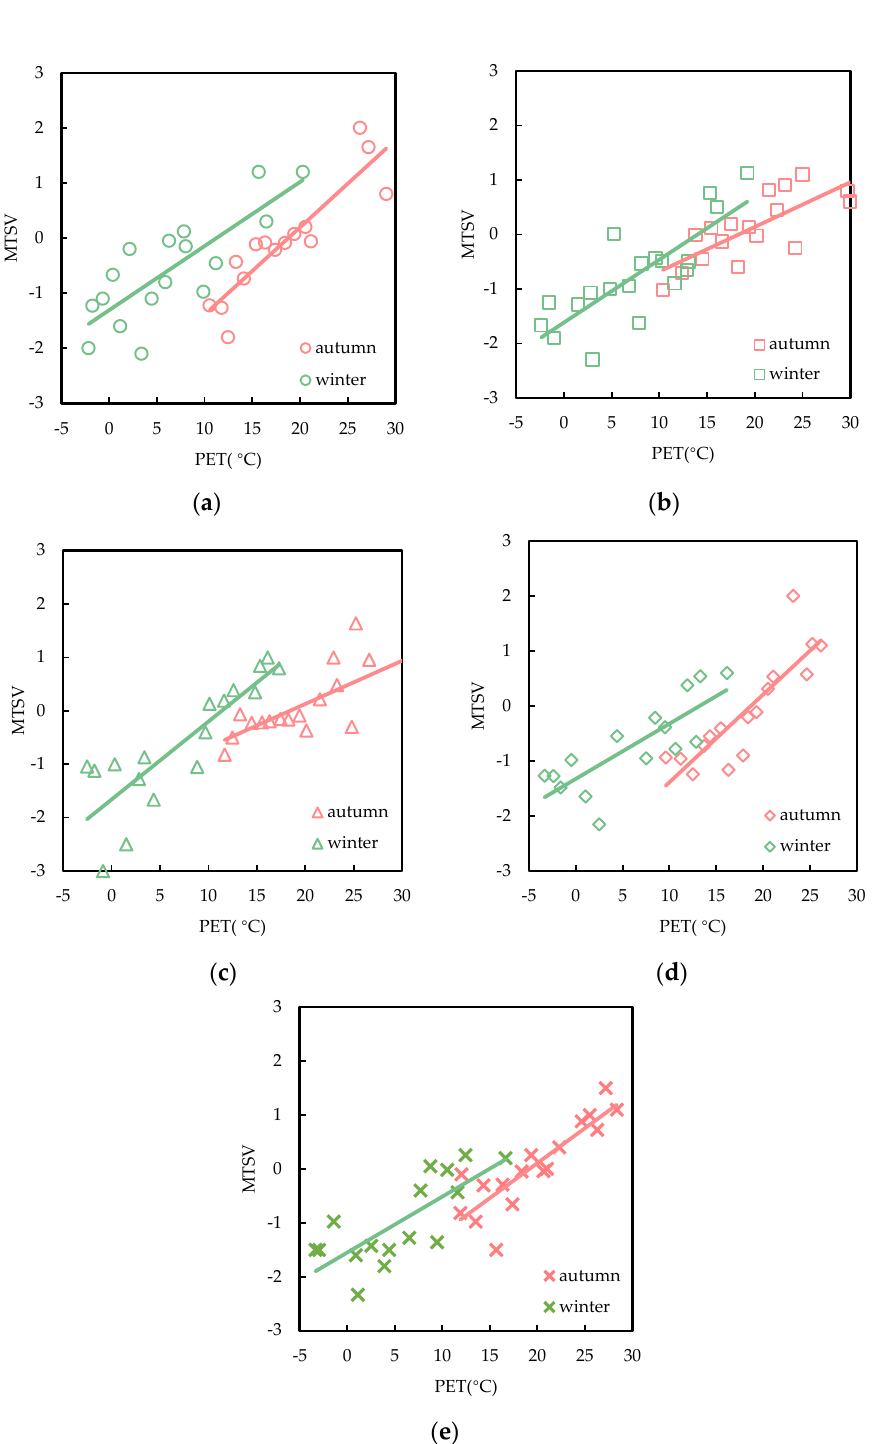
Figure 8. Correlation between PET and MTSV in different sound types: running water and birdsong ( a ), wind (a gentle breeze) and insects ( b ), broadcasting music ( c ), crowds ( d ), and machines ( e ). Table 5. Correlation between PET and MTSV in different sound types.